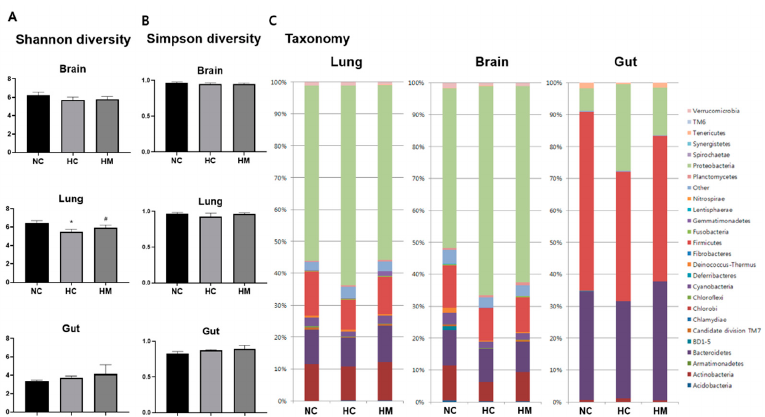
Figure 3. Microbiome diversity indices and relative abundances of microbial taxonomies in the brain, lungs, and gut. ( A ) Shannon and ( B ) Simpson diversity indices, and ( C ) relative abundances of microbial taxonomies in the brain, lungs, and gut. Data are presented as the mean ± standard deviation. Abbreviations: NC, normoxia control; HC, hyperoxia control; HM, hyperoxia with transplantation of human UCB ‐ MSCs. *, p < 0.05 compared with the NC group; #, p < 0.05 compared with the HC group. The hyperoxia ‐ induced increase in the abundance of lung Proteobacteria and de ‐ crease in the abundance of gut Firmicutes were significantly attenuated in the HM group (Table 1). Table 1. Relative abundance of phyla.